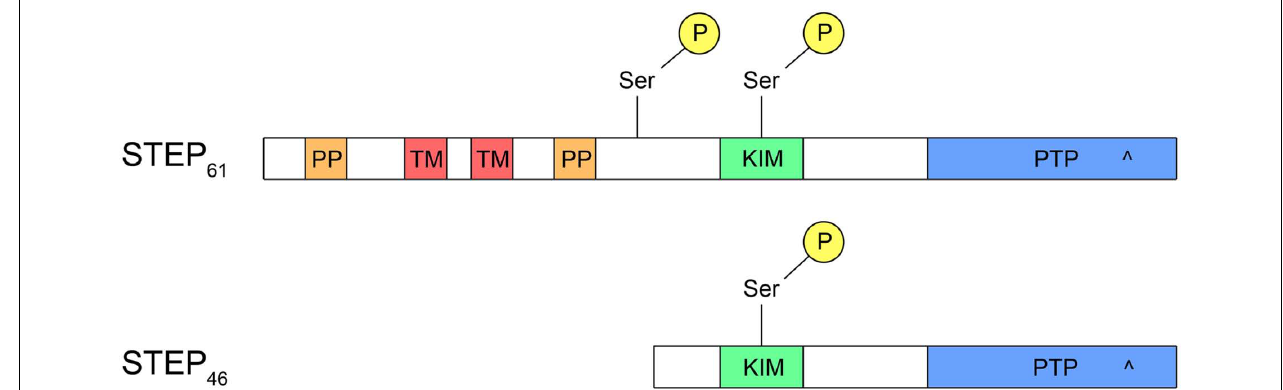
endoplasmic reticulum or postsynaptic density.Whereas STEP 61 has two serine (Ser) phosphorylation sites, STEP 46 contains only one within the KIM